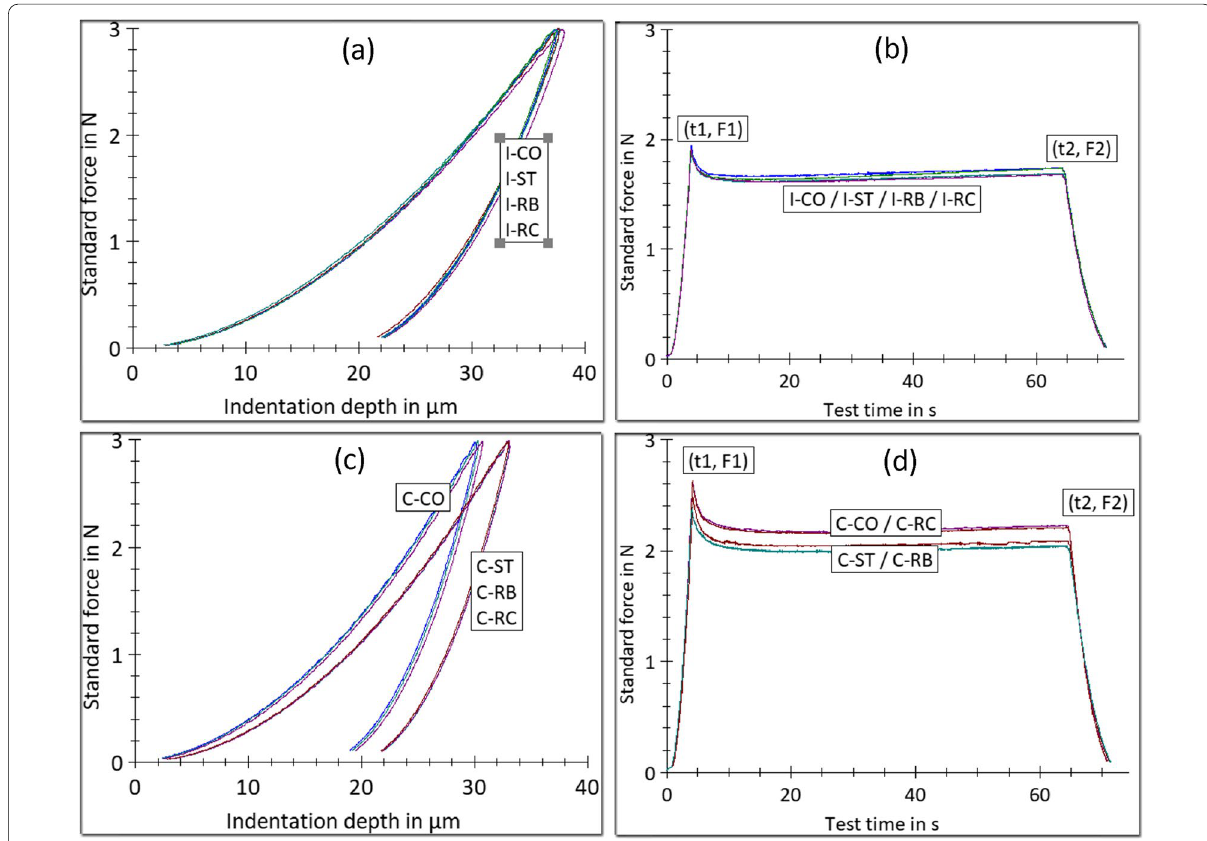
Fig. 1 Representative force–indentation depth ( a , c ) and force–time curves ( b , d ) for Clear Aligner (C) and Invisalign (I) appliances after immersion in Retainer Brite (RB), Retainer Cleaner (RC) and Steraligner (ST) solutions vs the controls (CO)